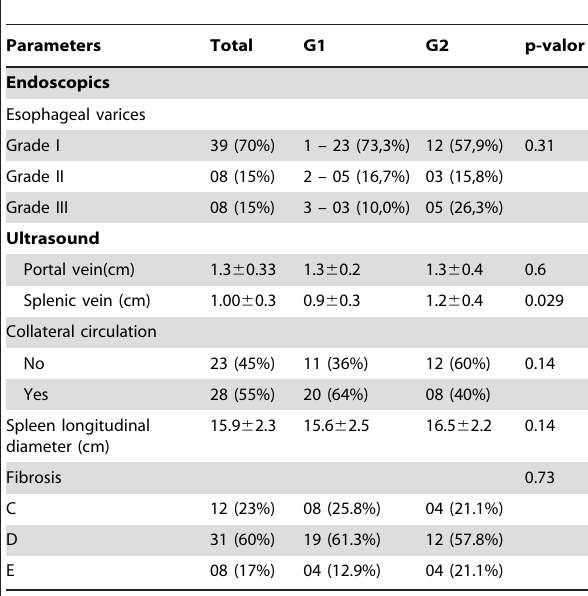
Table 2. Endoscopics and ultrasounds parameters.